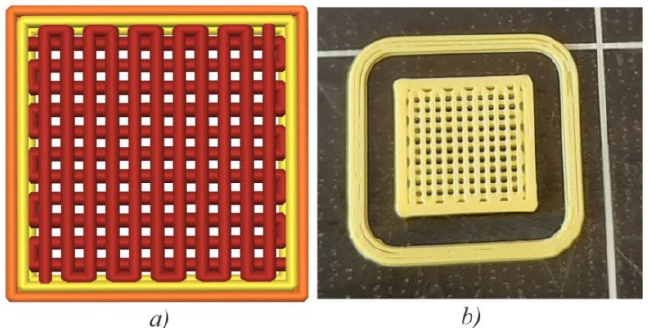
Figure 3. Scaffold prepared for 3D printing in Prusa Slicer ( a ), image of a 3D printed scaffold ( b ). Tensile strength and elasticity modulus tests were performed in compliance with the ISO 527- 2: 2012 specification, on a universal tester, Shimadzu EZ-LX , using 50 mm/min and 1 mm/min crosshead speed, respectively, at room temperature (24 °C).